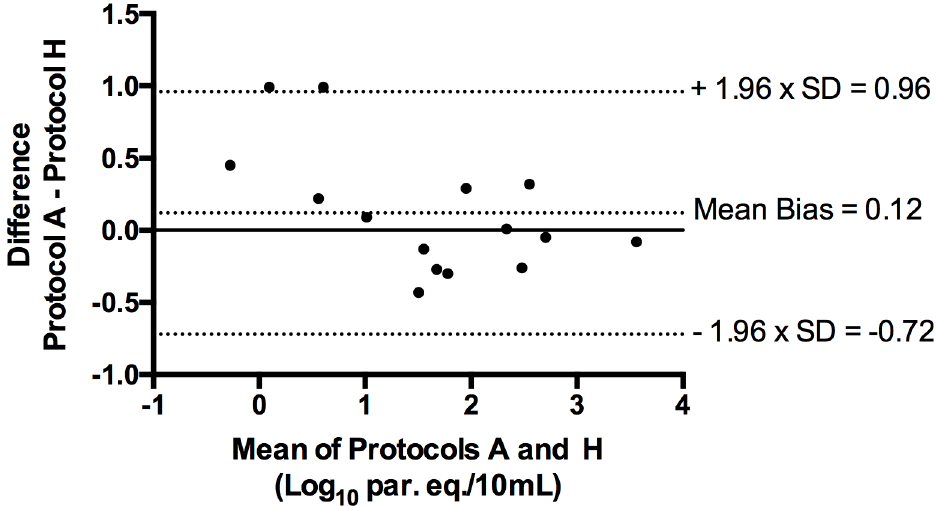
Fig 1. Degree of agreement between protocols A and H based on a Bland-Altman plot of the nine samples with quantifiable results in both methods. Each sample is represented by plotting the mean of the measurements obtained in protocols A and H on the x-axis and the difference of the same two values on the y-axis. SD: standard deviation. Log 10 par. eq./10 mL: logarithmic values of parasite equivalents in 10 mL of